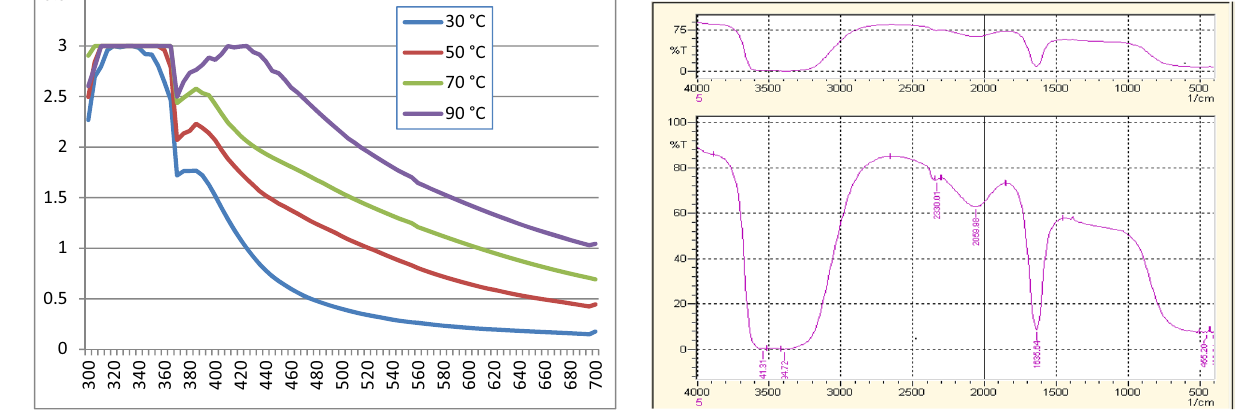
Figure 6: FTIR spectrum of methanolic nanoparticles of Tropaeolum majus